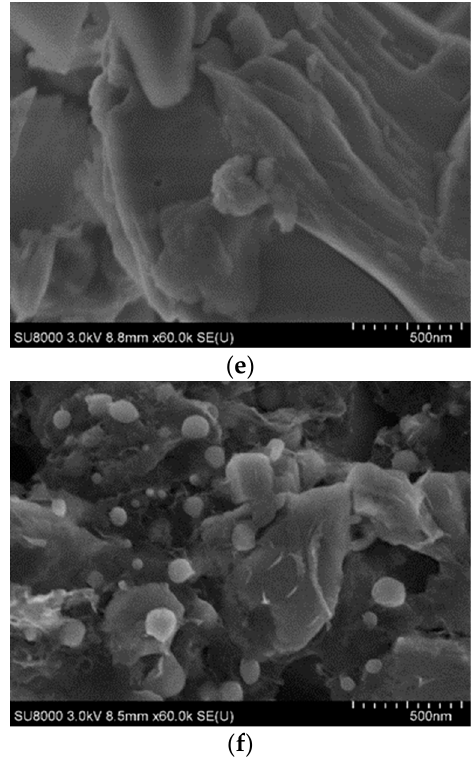
Figure 14. ( a ) Scanning electron microscope image of granite particles (×1000); ( b ) Scanning electron microscope image of OSW particles (×1000); ( c ) Scanning electron microscope (SEM) image of granite particles (×10,000); ( d ) Scanning electron microscope image of OSW particles (×10,000); ( e ) Scanning electron microscope image of granite particles (×60,000); ( f ) Scanning electron microscope image of OSW particles (×60,000).